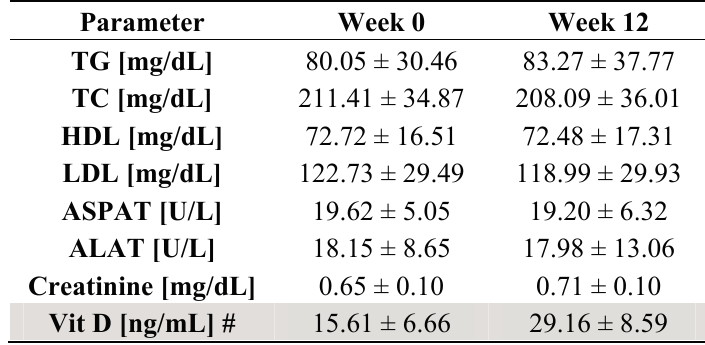
Table 1. Selected cardiovascular risk factors after NucleVital ® Q10 Complex intake. Values are presented as mean ± SD. TG = triglycerides; TC = total